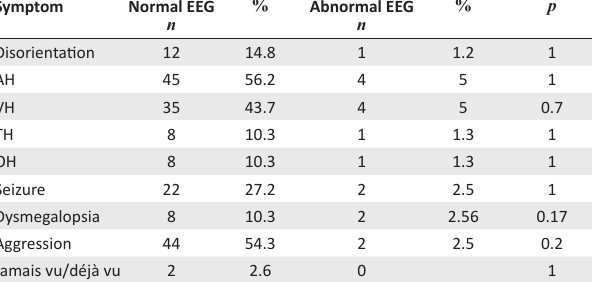
FIGURE 1: Reason for referral to electroencephalography. TABLE 1: Electroencephalography results matched with symptoms. Symptom Normal EEG n